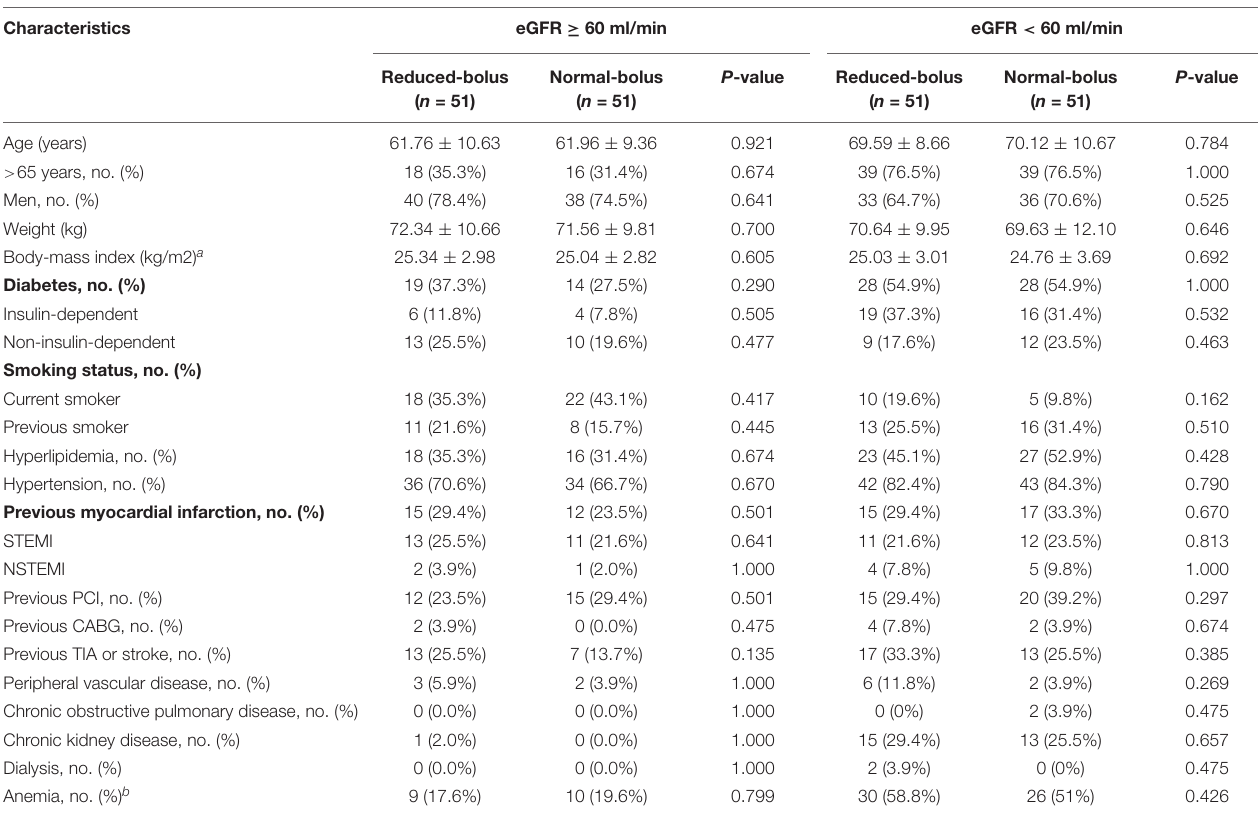
TABLE 1 | Baseline characteristics according to the randomized treatment.